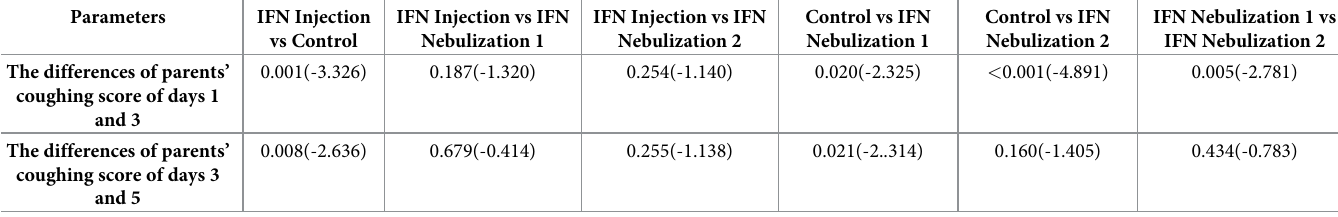
Table 7. The P values of pairwise comparisons for the differences in coughing score as assessed by the parents by Mann—Whitney U test. (Z values in the parenthesis).